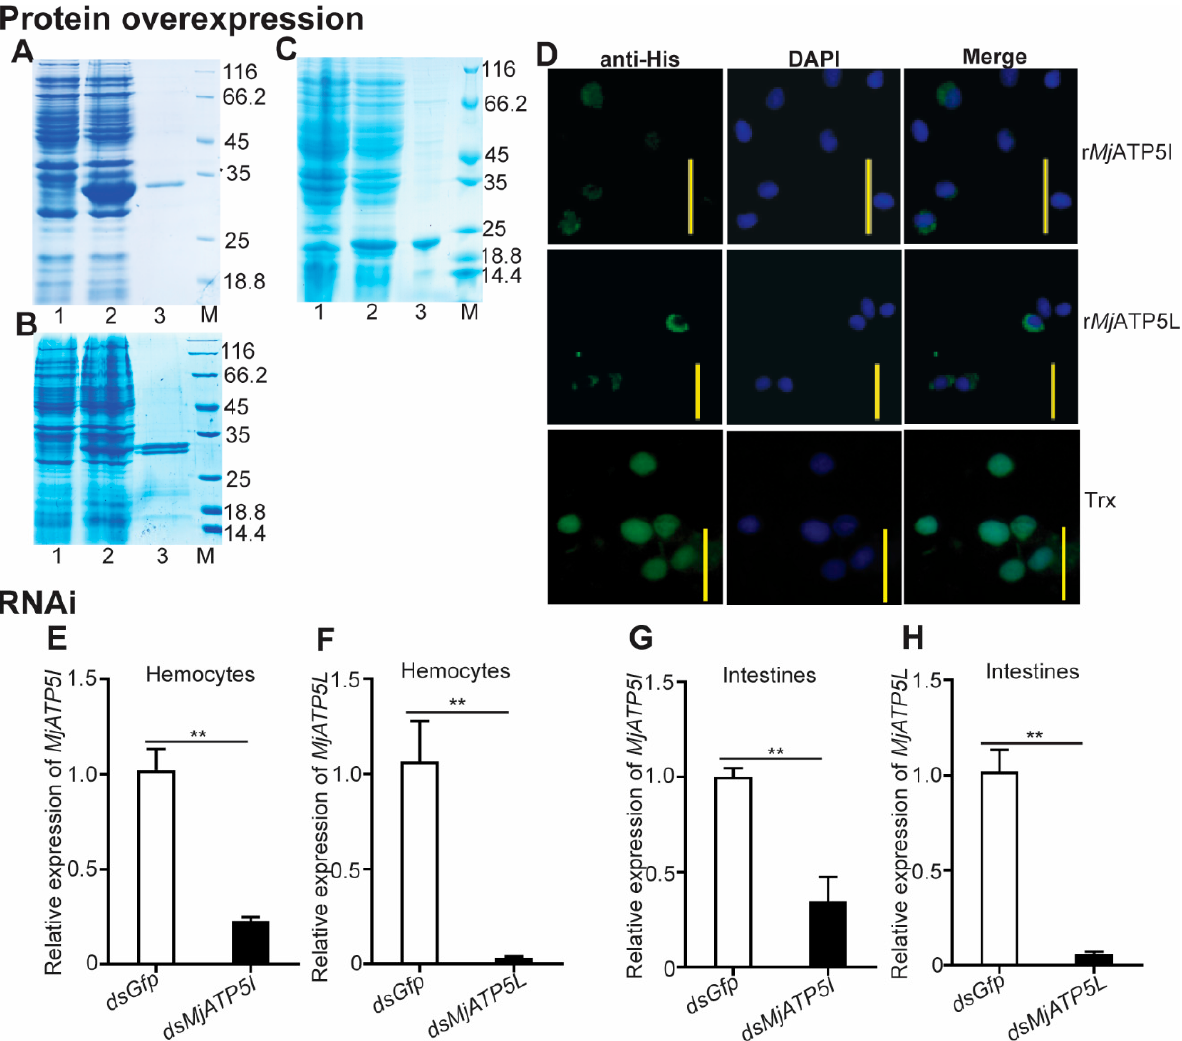
Figure 4. Recombinant protein injection and RNAi effect detection for Mj ATP5I and Mj ATP5L in shrimp. The recombinant expression and protein purification of Mj ATP5I ( A ), Mj ATP5L ( B ), and